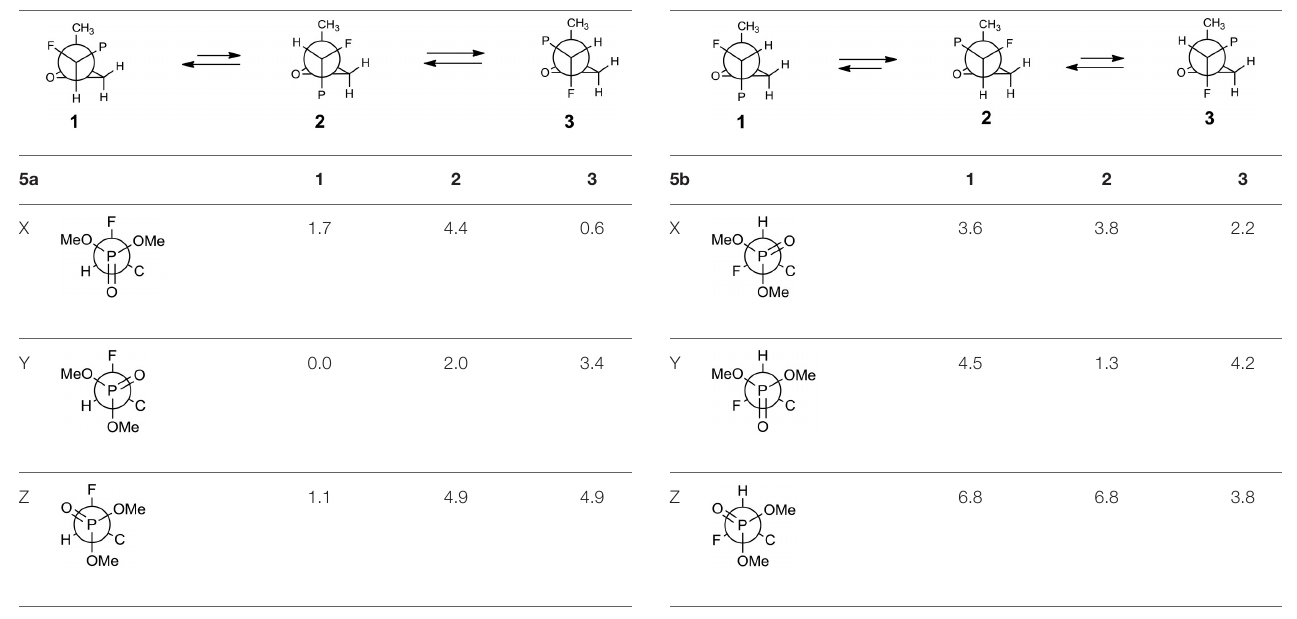
TABLE 3 | The geometries and relative energies [kcal/mol] of nine energy minima for the compound 5b